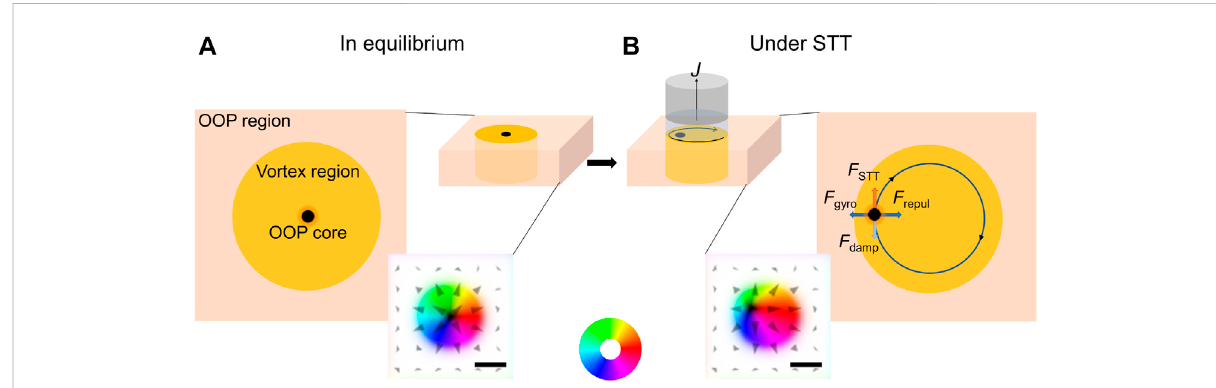
out-of-plane (OOP) anisotropy and a core with out-of-plane magnetisation is induced: (A) in equilibrium and (B) in oscillation under spin-polarised current.Theinsetsshowthemagnetisationcon fi gurationofthesimulatedarea.Magnetisationalongthe+ z and – z directionisindicatedinwhiteand black, while the magnetisation direction in the vortex region is given by the colour wheel. Scale bar: 50 nm.